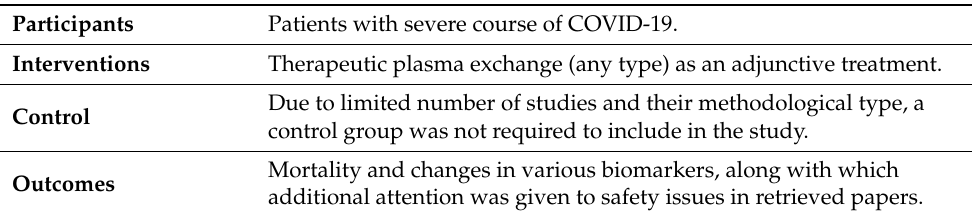
Table 1. The PICO criteria used in the